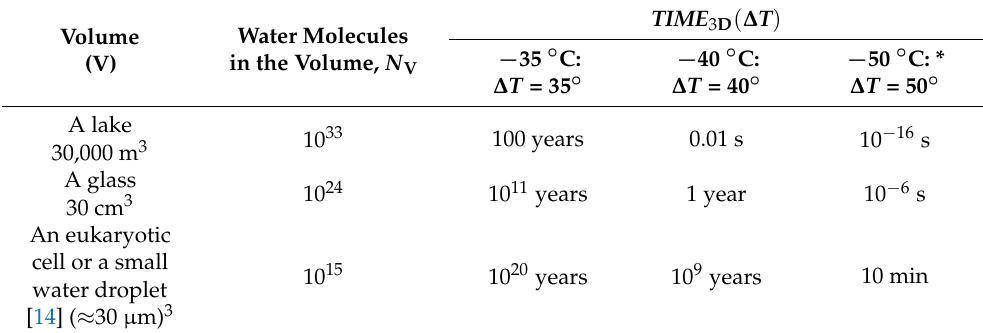
Table 1. Time of homogeneous ice nucleation in bulk water in the absence of ice-binding surfaces †